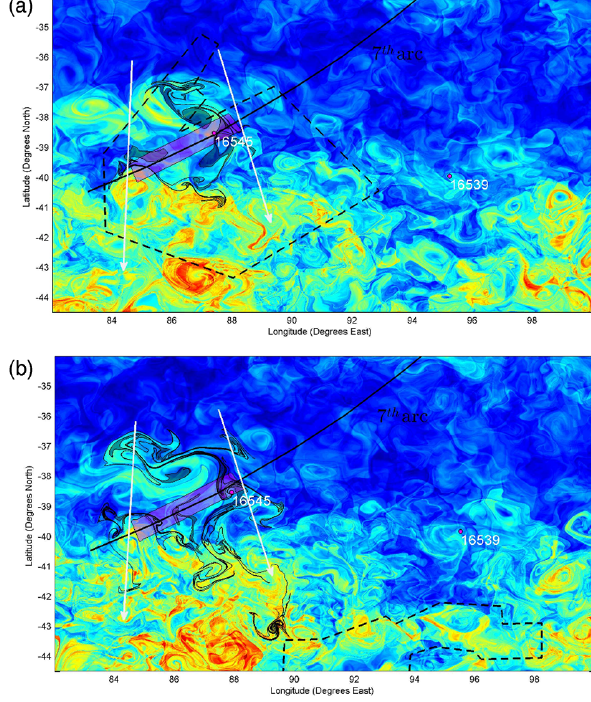
Figure 3. A summary of the debris search for the Malaysian MH370 plane in the southern Indian Ocean. In the background the M func- tion, evaluated on HYCOM data for τ = 15 days at 50m depth, high- lights mesoscale structures and invariant manifolds. Overlapped are the drifters in the area (magenta dots), the expected flight paths (white arrows), the likely impact area (pink) and its contour evolu- tion (gray). Dashed lines outline the search areas for the respective dates, (a) 19 March 2014 and (b) 27 March